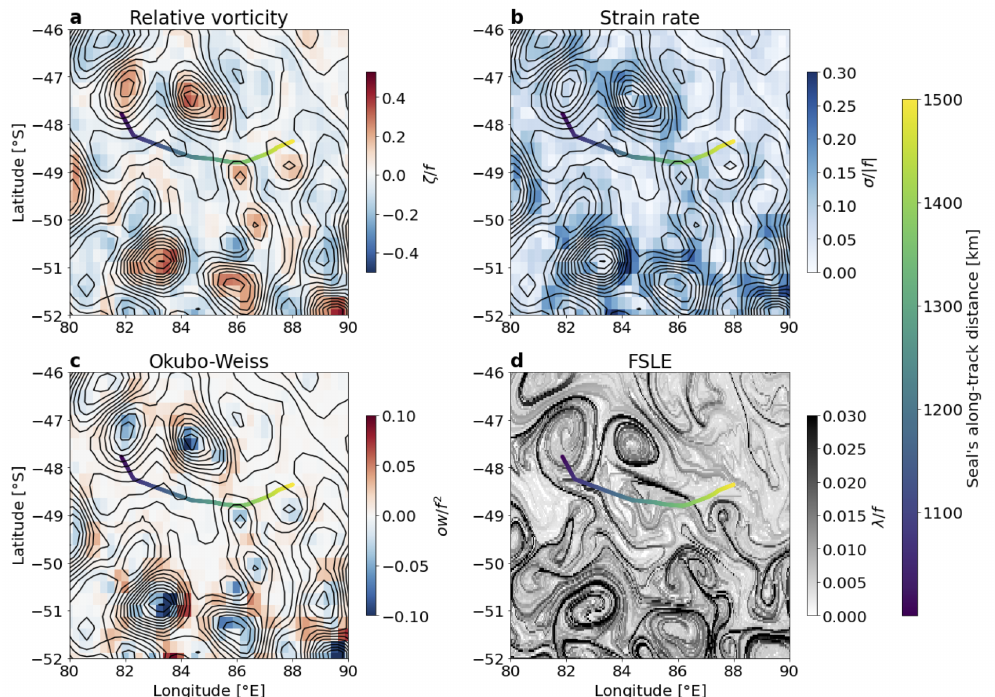
Figure 11. Map of physical quantities derived from AVISO SSH on 11 November 2018 (i.e., at the seal’s mid-date trajectory). ( a ) Relative vorticity normalized by f . ( b ) Strain rate normalized by f . ( c ) Okubo-Weiss quantity normalized by f 2 . ( d ) FSLE normalized by f . The seal’s transect is colored by its along-track distance. Note that the mesoscale eddy field considerably evolved during the seal’s